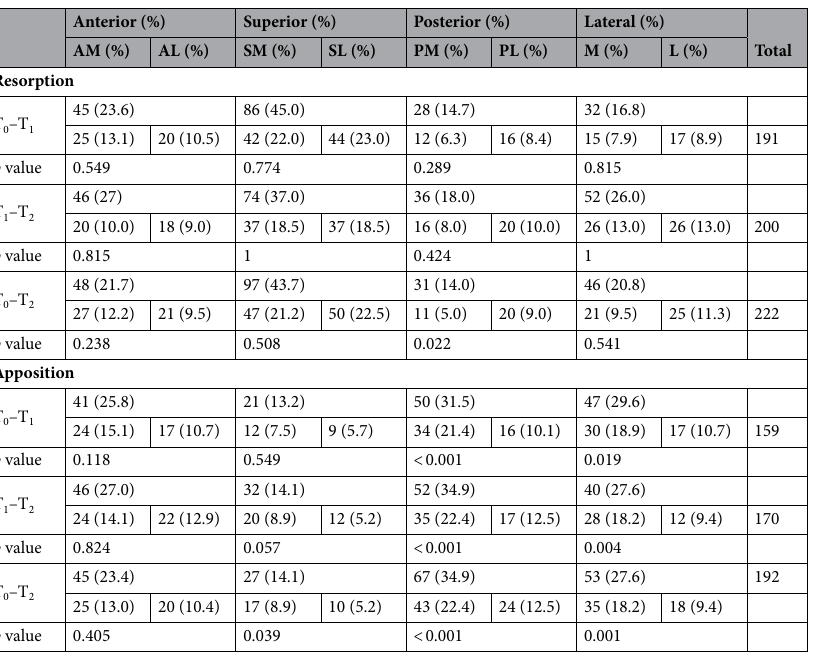
Table 2. Condylar remodeling type frequencies in each section. Values are expressed as number (percentage). Percentage of total remodeling that occurred at each time point in the anterior, superior, posterior, and lateral regions. The differences in frequency between medial and lateral parts of the anterior, superior, posterior, and lateral regions are indicated by the p value. AL anterolateral, AM anteromedial, SL superolateral, SM superomedial, PM posteromedial, PL posterolateral, M medial, L lateral, T 0 initial timepoint, T 1 middle timepoint; T 2 final